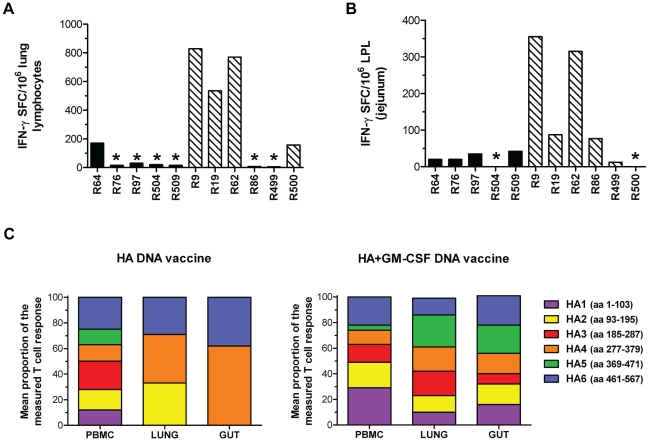
The GM-CSF genetic adjuvant increases both the magnitude and breadth of mucosal T cell responses elicited in the lungs and guts following PMED HA DNA vaccination.HA-specific T cell responses in the (A) lung and (B) gut mucosa of macaques were determined by IFN-γ ELISpot assay 4–11 weeks after the final vaccination with HA DNA (solid bars) or HA DNA+GM-CSF (hatched bars). Individual bars represent the peak number of HA-specific IFN-γ T cells detected in the jejunum and lung tissue of individual animals 4–11 weeks after the final vaccination. (C) Breadth of the IFN-γ T cell response in PBMC, lung, and gut. HA-specific T cell responses in the indicated tissues were measured using a standard IFN-γ ELISpot assay with 6 individual pools of overlapping peptides (11 amino acid overlaps, 103 15-mers per pool) comprising the entire amino acid sequence of the influenza A/New Caledonia/20/99 HA protein. The percent contribution of each peptide-pool specific response to the total response was determined by dividing the mean number of IFN-γ spot forming cells (SFC) measured against each individual peptide pool by the sum of the response against all peptide pools. Results represent the average of 2 time-points tested after the 3rd DNA dose (weeks 19 and 23). *Measurement below positive threshold level for the assay.